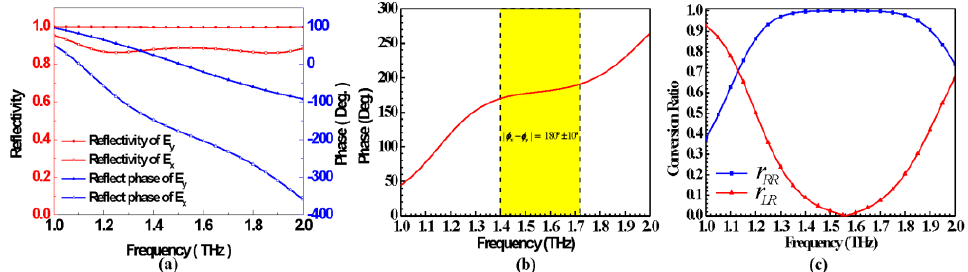
Figure 3. ( a ) Simulated reflection performance of the PB unit-cell under the normal illumination of x- and y- polarized plane waves. The red and blue curves represent the amplitude and phase of the reflected wave, respectively. Optimizing geometric parameters w = 13.39 µm and l = 3.2 µm are chosen in the simulation. ( b ) Simulated phase differences of the x- and y- polarized reflected waves. Yellow area in the figure demonstrates the frequency range of a nearly 180° phase difference. ( c ) Simulated co-polarized and cross-polarized conversion ratios under the normal RHCP incident plane wave. The blue and red curves represent the co-polarized conversion ratio and cross-polarized conversion ratio, respectively.